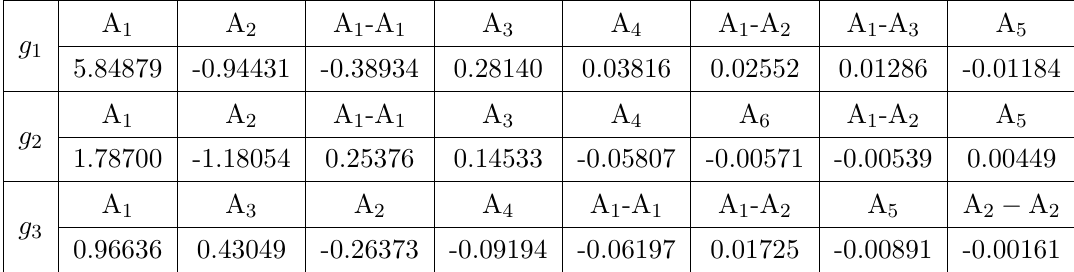
Table 1 . Contributions to g a at order (cid:21) 2 sorted by magnitude, with the particle content of the inserted state shown in the top